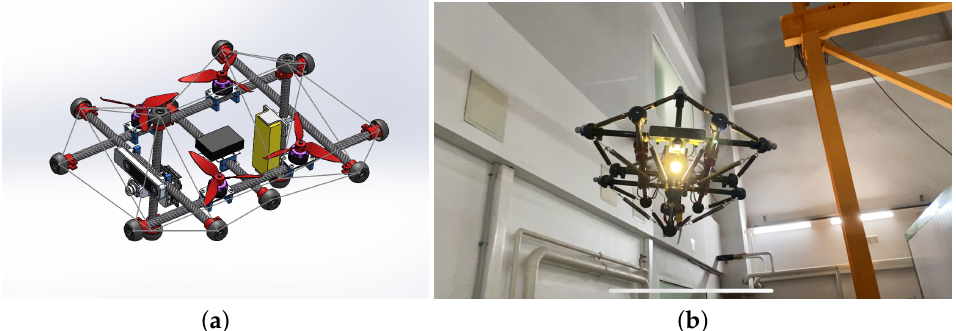
Figure 8. Second generation tensegrity drone. ( a ) CAD model. ( b ) In-flight